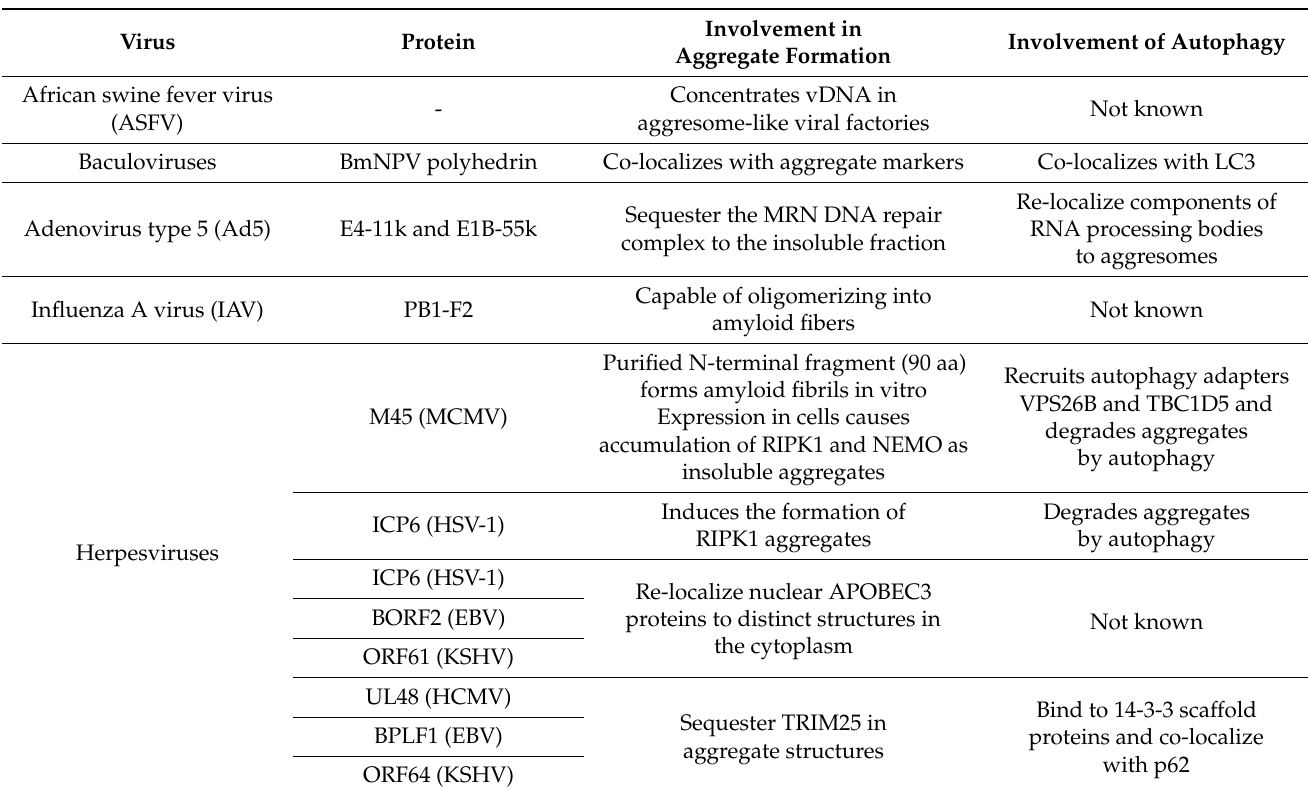
Table 2. Viruses and aggregate formation. Examples of viral proteins involved in aggregate formation and their involvement in the autophagic